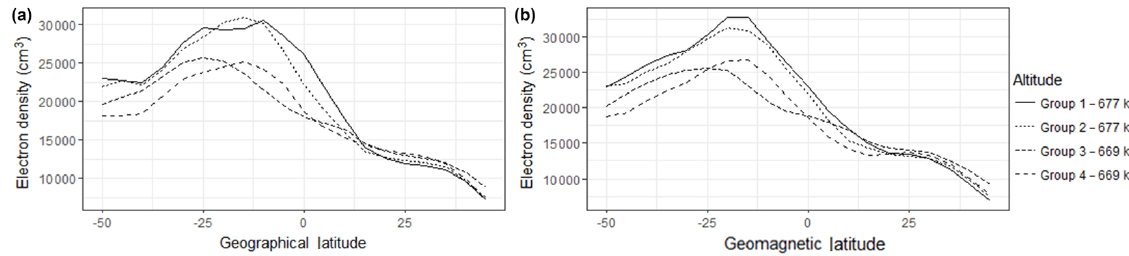
Figure 6. Variation in the average ascending electron density with latitude.